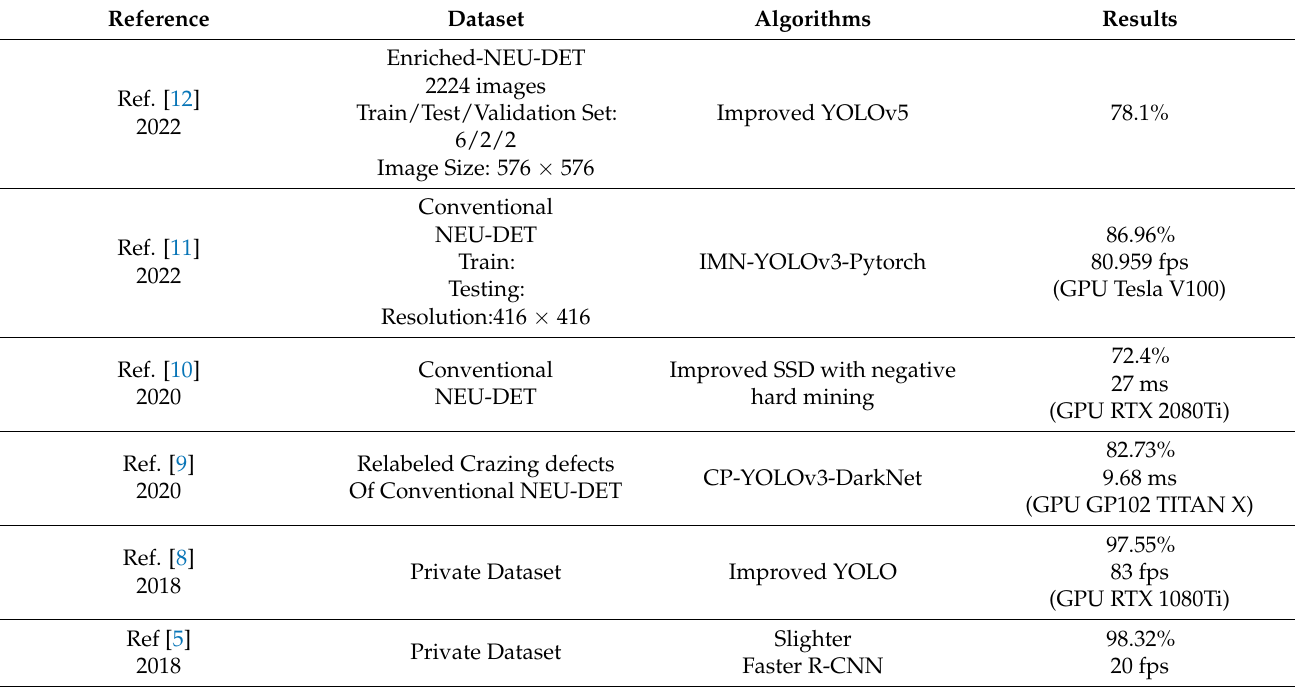
Table 1. Related work of steel surface defect detection algorithms. Reference Dataset Algorithms